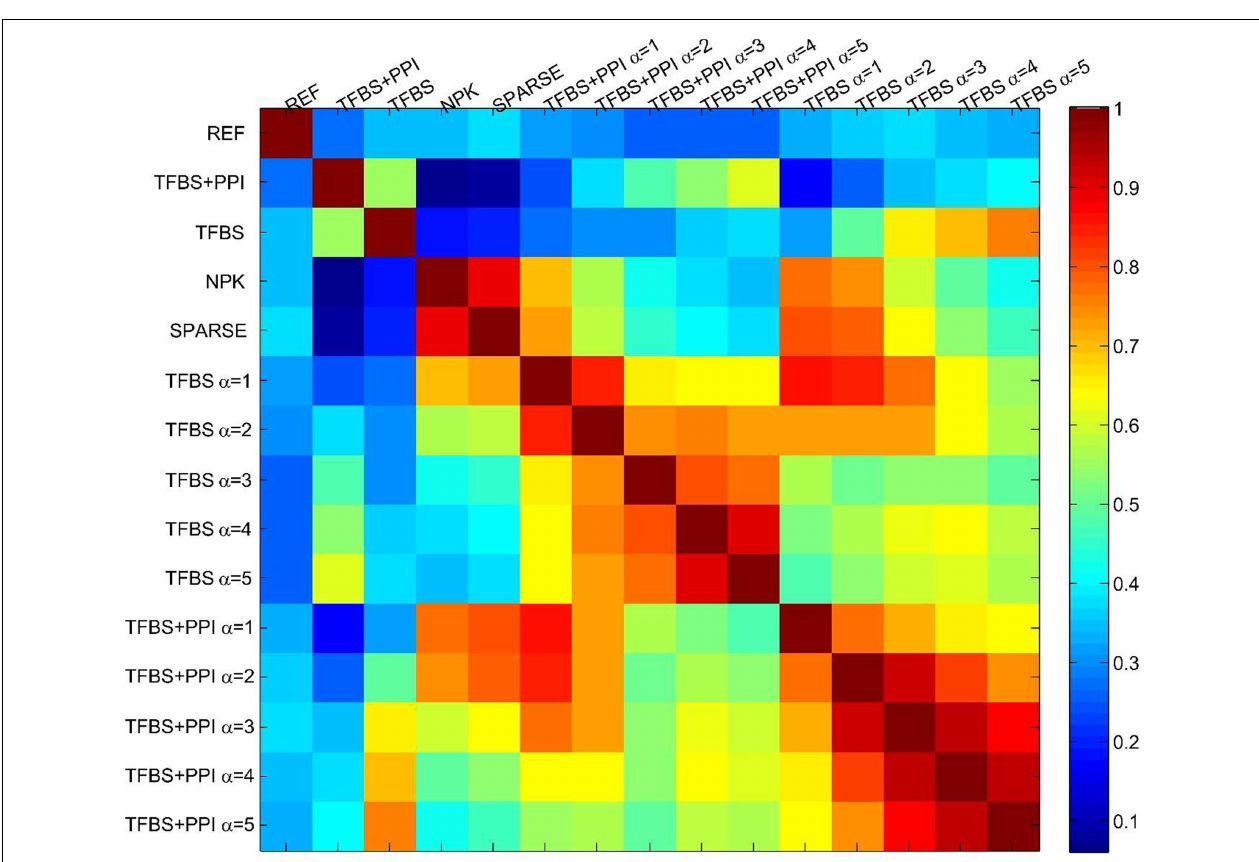
among the reference, prior, and posterior networks.Values close to 1 (dark red) represent close agreement and values close to zero (dark blue) represent a lack of agreement between network topologies.This figure suggests that the prior networks (TFBS andTFBS + PPI) do not have significant overlap with the reference network (correlation coefficients 0.42, 0.31, respectively).This is due to the fact that only 19 and 16% of the interactions that are present in the prior networks (TFBS andTFBS + PPI) are also present in the reference network (REF). Additionally, posterior networks inferred from the same prior network have a high degree of topological similarity (correlation coefficients 0.6–0.95), regardless of the value of the confidence parameter ( α c